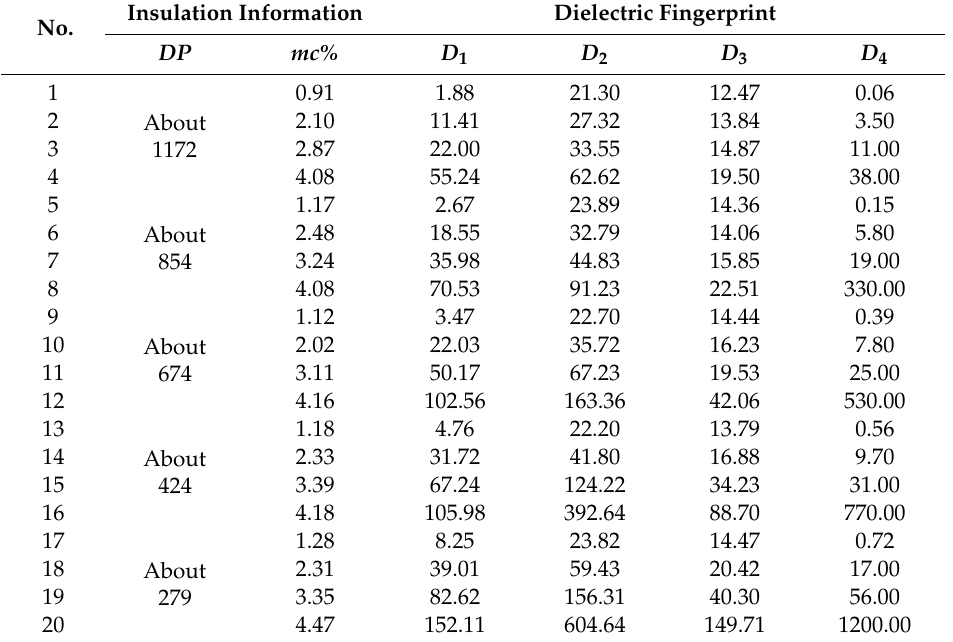
Table 3. Dielectric fingerprints ( D 1 – D 4 ) of prepared oil-immersed pressboards.